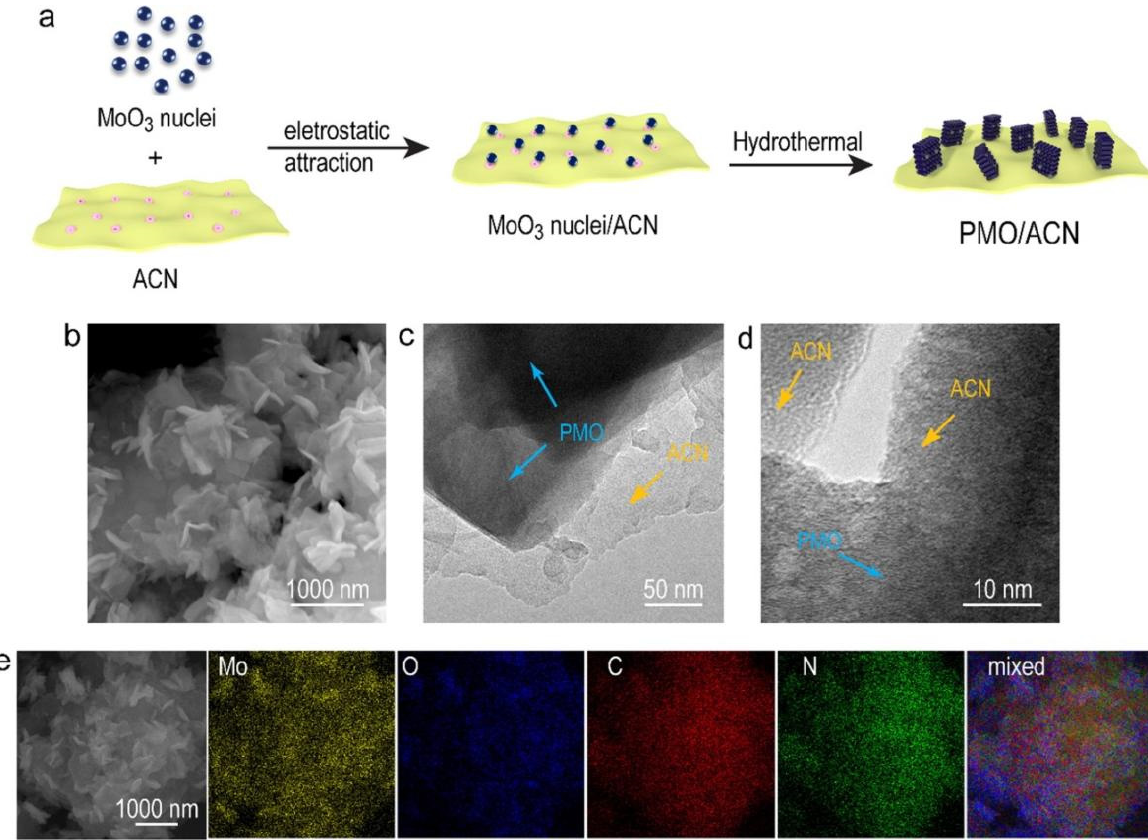
Figure 6. Synthesis of the PMO/ACN nanohybrid. ( a ) Schematic illustration for the synthesis of PMO/ACN, ( b ) SEM, ( c ) TEM, ( d ) HRTEM images of the PMO/ACN sample and ( e ) SEM elemental mapping for the PMO/ACN nanohybrid. Used with permission from [107]. Copyright 2020 Else- vier.